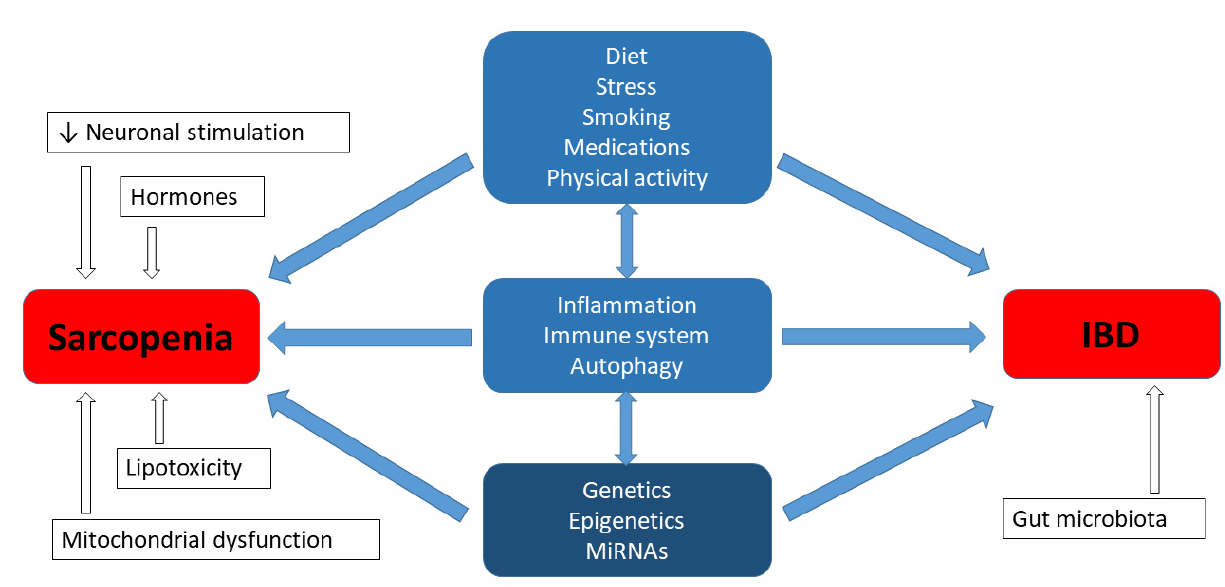
Figure 1. Genetics in aetiology of sarcopenia and IBD.